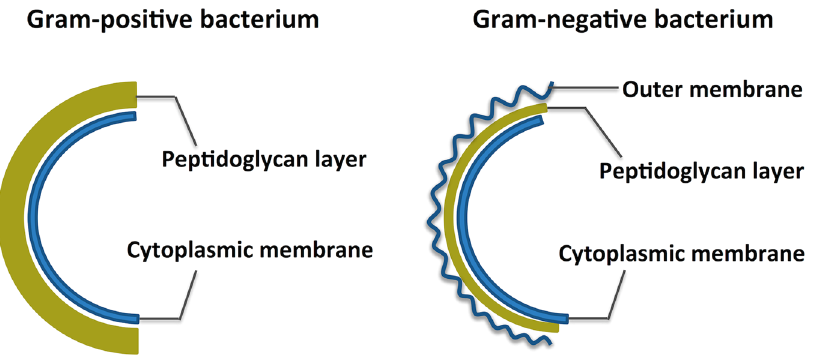
Figure 6. Structure schematic of Gram-positive and Gram-negative